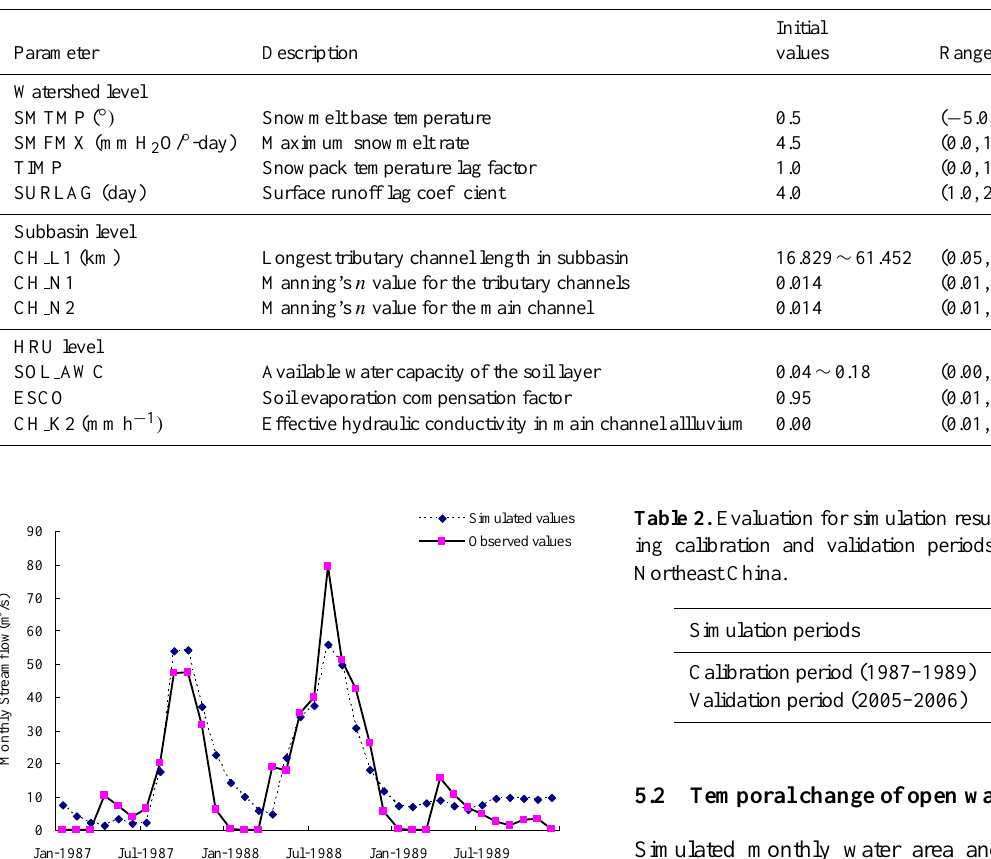
Table 1. Major model parameters and their settings for the Zalong wetland modeling.